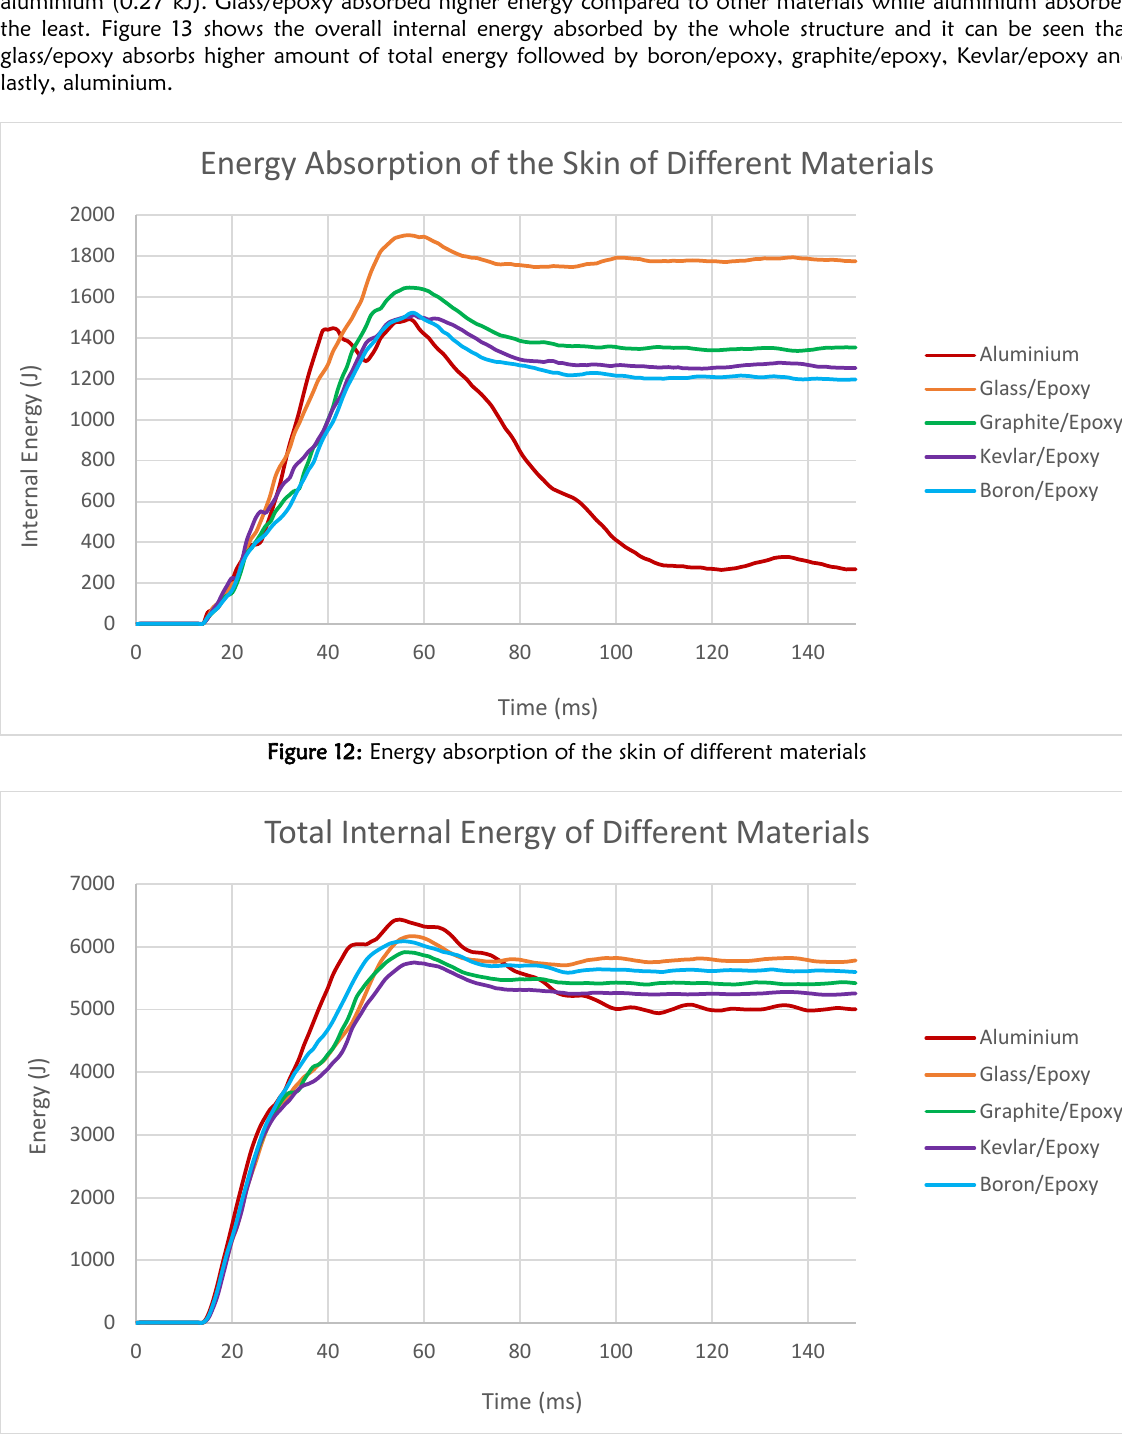
Figure 13: Total internal energy of fuselage made of different composite materials with unidirectional